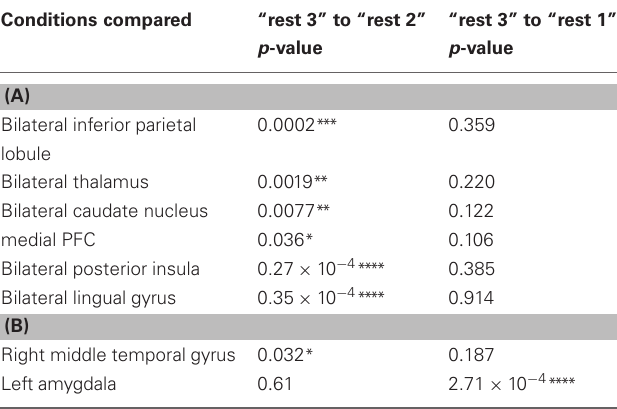
Table 2 | (A) Fisher’s LSD post-hoc comparisons between rsFC with the PCC seed ROI in different rest conditions; (B) Fisher’s LSD post-hoc comparisons between rsFC with the hippocampus seed in different rest